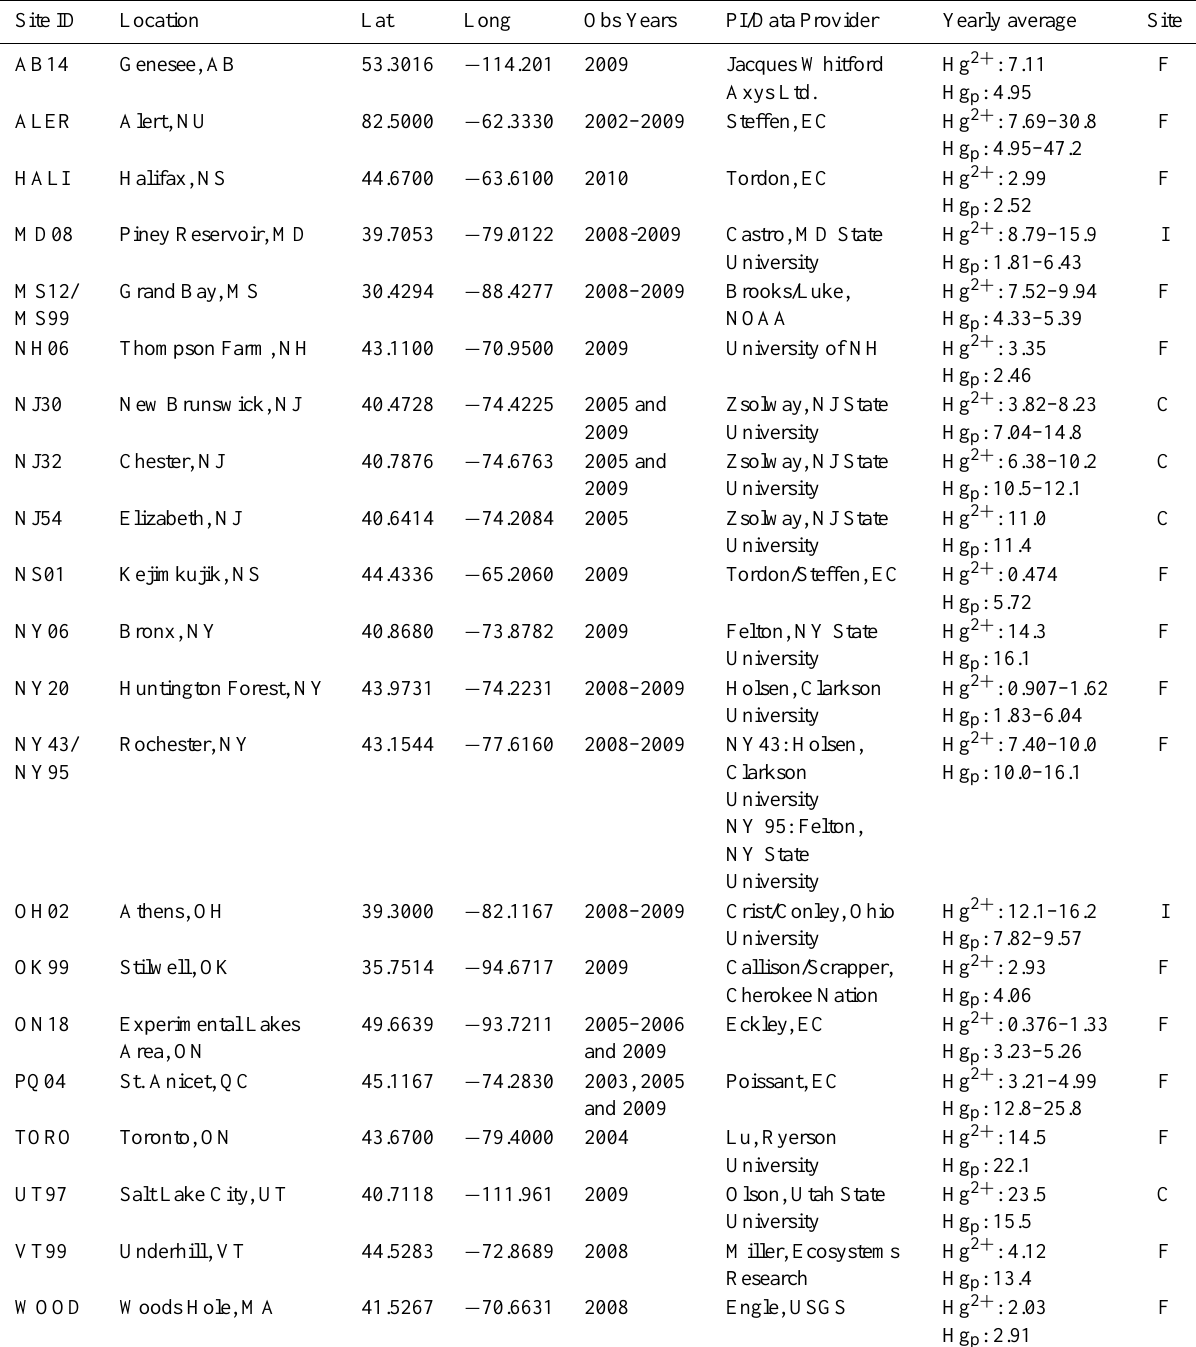
Table 4. Observation sites for data used in this study. Two site identifiers at the same location indicate co-located instrument data. Yearly means (pgm − 3 ) for multiple years are similar. Sites were classified as C = close (60–90pgm − 3 ) , and I = intermediate proximity to